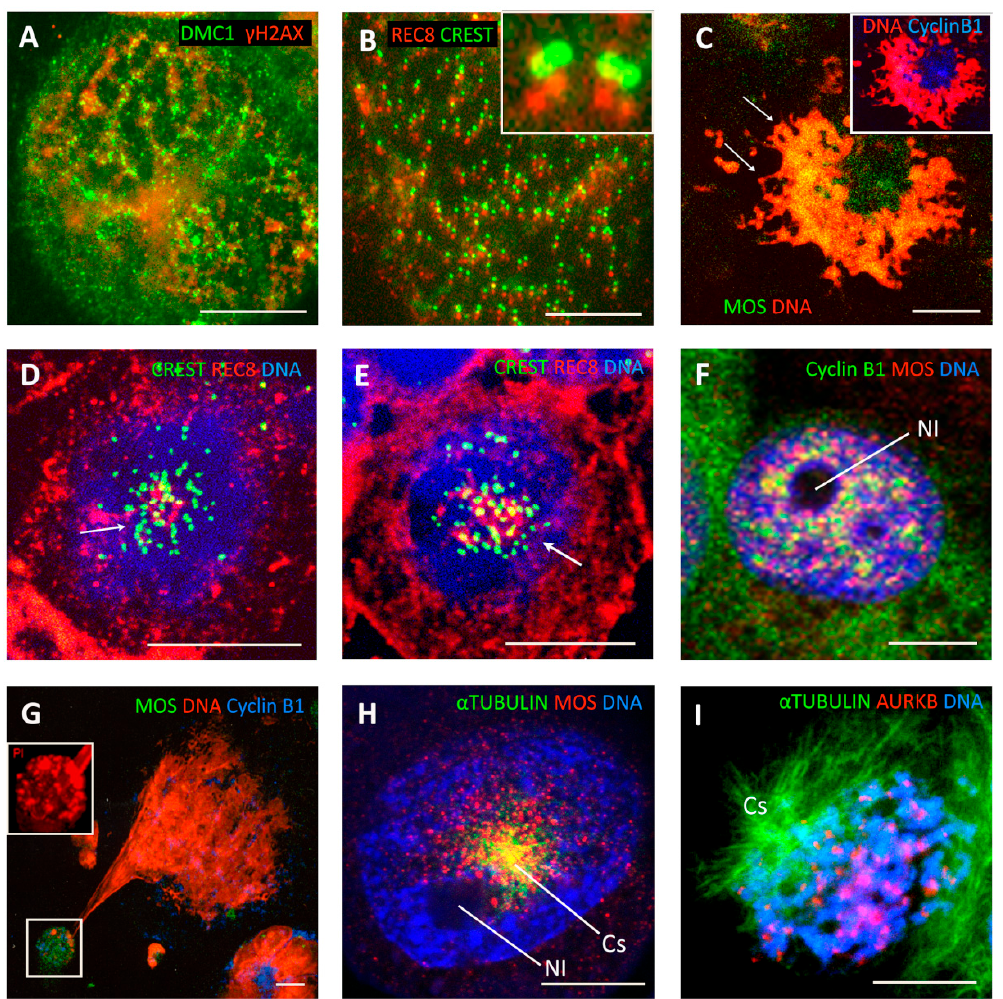
Figure 3. Features of monopolar meiotic endo-prophase in treated tumour cells. ( A ) WIL2-NS cell 6 days post 10 Gy, showing a looped pattern of DNA strands (inferred from chains of tandemly situated foci of DMC1 (red) and γ -H2AX (green) indicating homologous recombination repair of DNA DSB. ( B ) Detail of a WIL2-NS cell nucleus, 5 days post 10 Gy, displaying tandem arrays of kinetochore doublets (green) colocalised with REC8 (red). The boxed and enlarged insert is a typical pattern of kinetochore doublets and REC8 signals. The red and green foci are offset to better demonstrate their colocalisation (reproduced with permission [38]). ( C ) Confocal section of a Namalwa lymphoma cell (6 days post 10 Gy), showing a central location of MOS (green) and CYCLIN B1 (blue). DNA is stained red by propidium iodide. ( D , E ) Confocal sections of WIL2-NS cells (5 days after 10 Gy), showing a single cluster of centromeres (arrow) colocalised with REC8. ( F ) The association of MOS (red) and CYCLIN B1 (green) with the perinucleolar rim (Nl: nucleolus) and their radial strands in a MDA MB 231 cell (2 days after DOX treatment). ( G ) The polar cluster of heterochromatin (boxed; DNA (red) stained with 7-AAD) colocalised with MOS (green) CYCLIN B (blue) in a late endo-prophase. ( H , I ) Monopolar spindle in a late endo-prophase in MDA MB 231 DOX-treated cells. ( H ) Centrosomal monoastral MTs (green) with granular MOS signals (red) on microtubules radiating from near the nucleolus (Nl), (4 days post DOX-treatment). ( I ) A monopolar (MTs green) diakinetic endo-prophase revealing largely tandem radial arrays of AURKB (red) positive kinetochore doublets on chromosome pairs (DNA blue) in a 3D-preserved sample. Bars equal 10 µM.